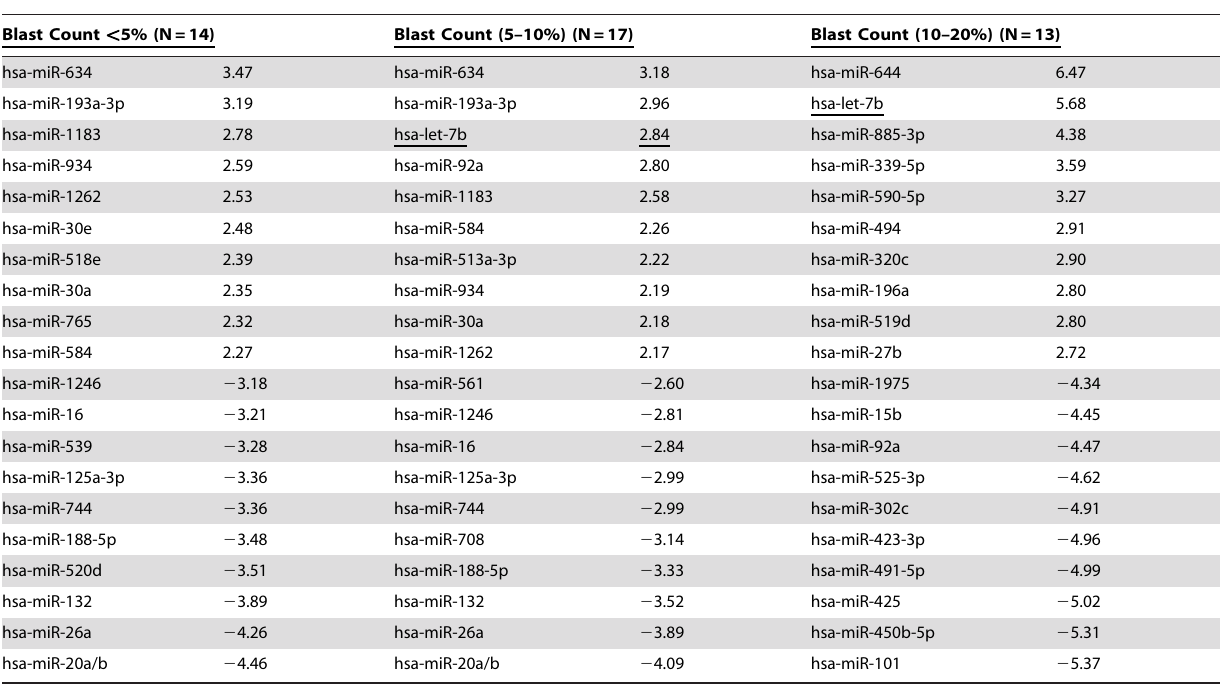
Table 1. MiRs expression in CD34 + MDS marrow cells ordered by blast count.